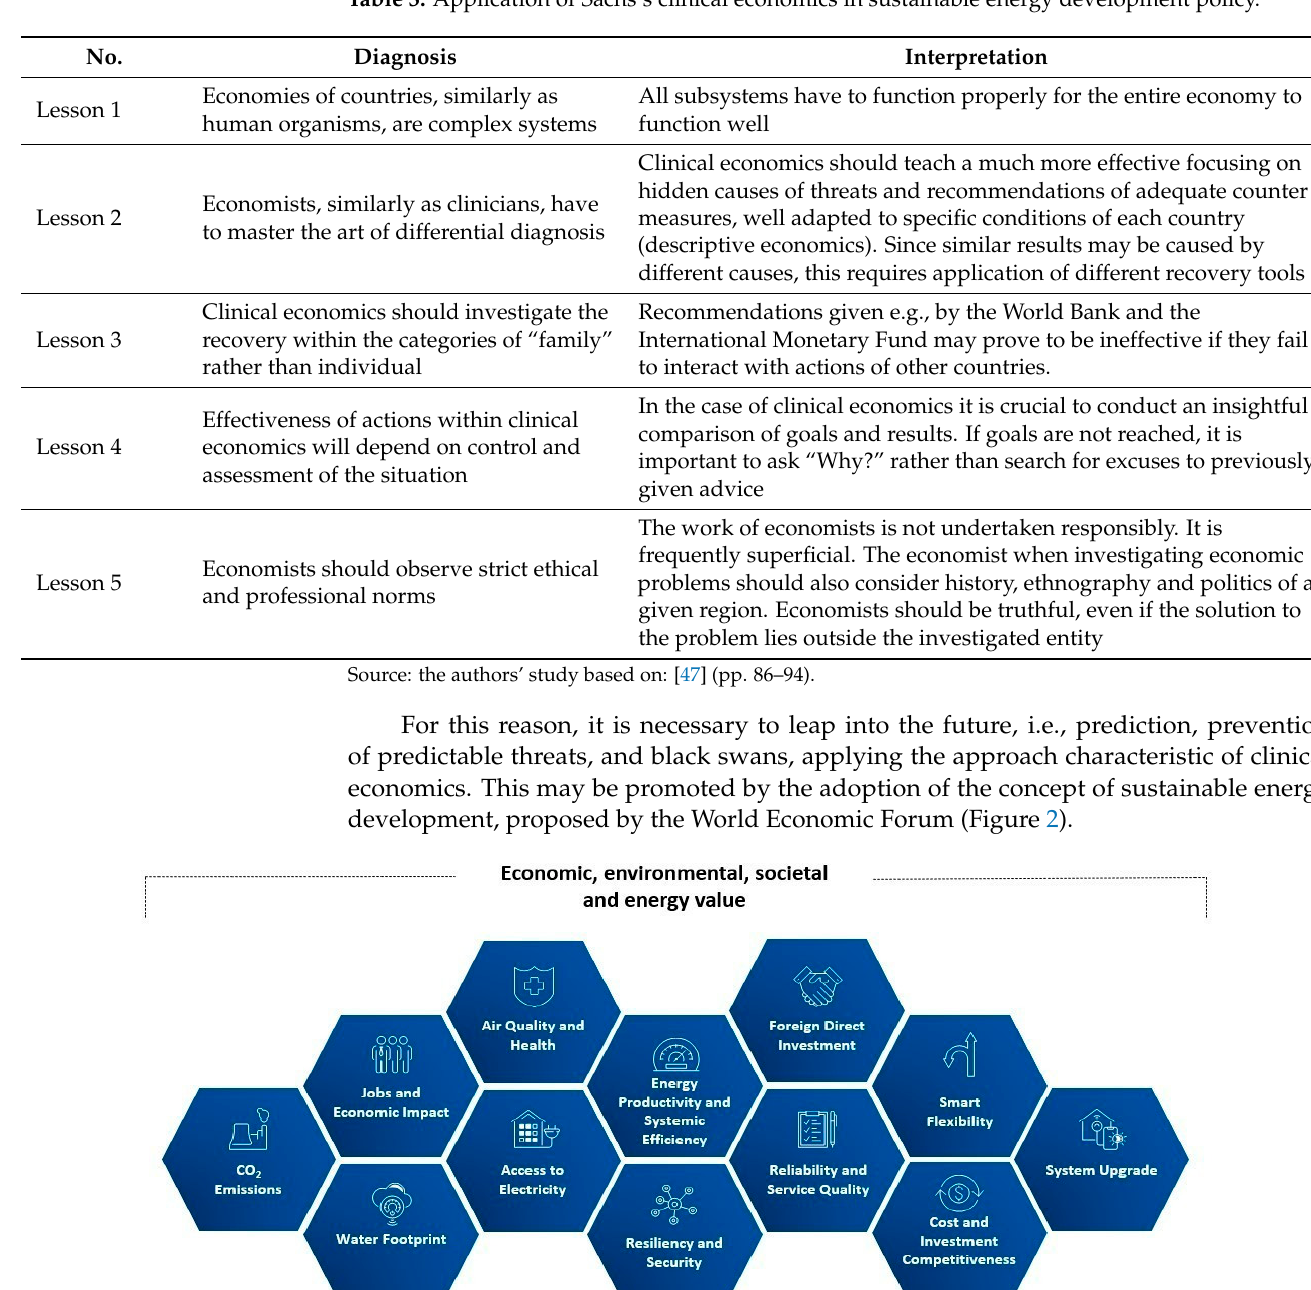
Table 3. Application of Sachs’s clinical economics in sustainable energy development policy.